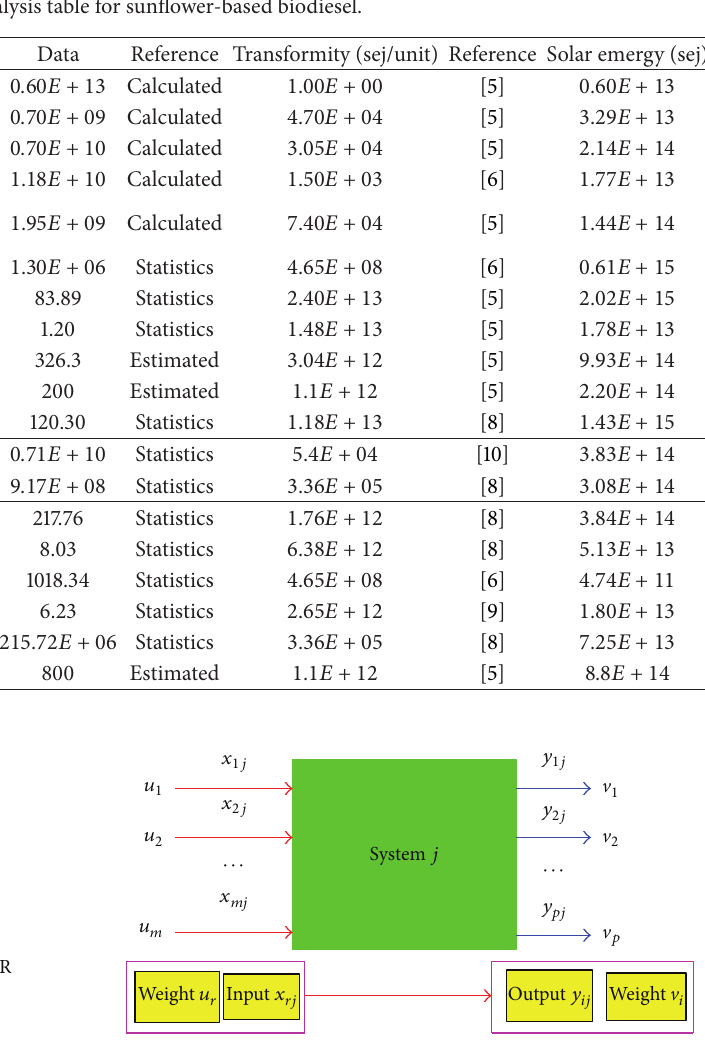
Table 5: Emergy analysis table for sunflower-based biodiesel.